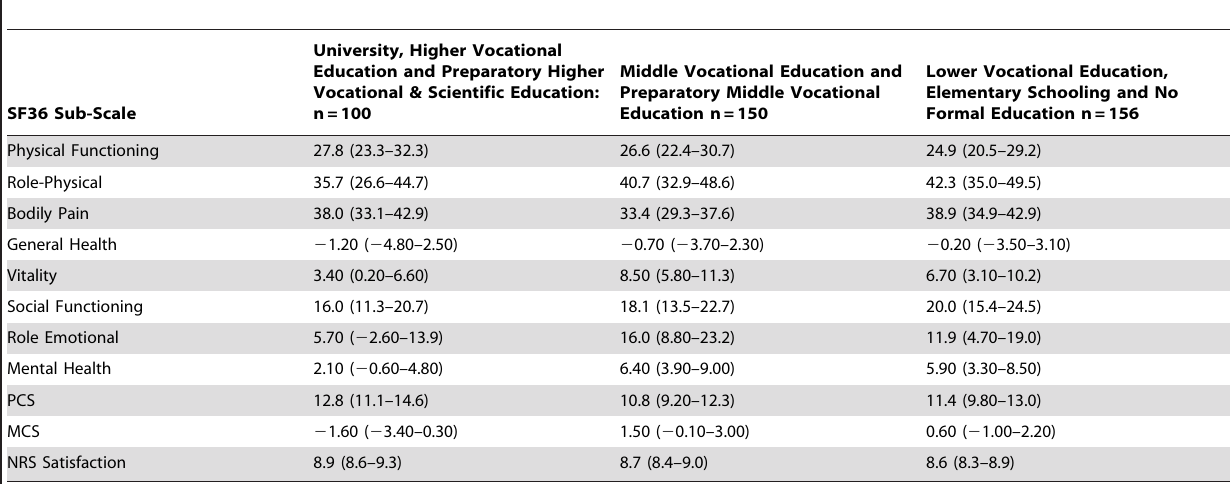
Table 4. Improvement in Health-Related Quality of Life and Satisfaction after Hip Replacement:: A Comparison Between Patients with different Completed Levels of Schooling.